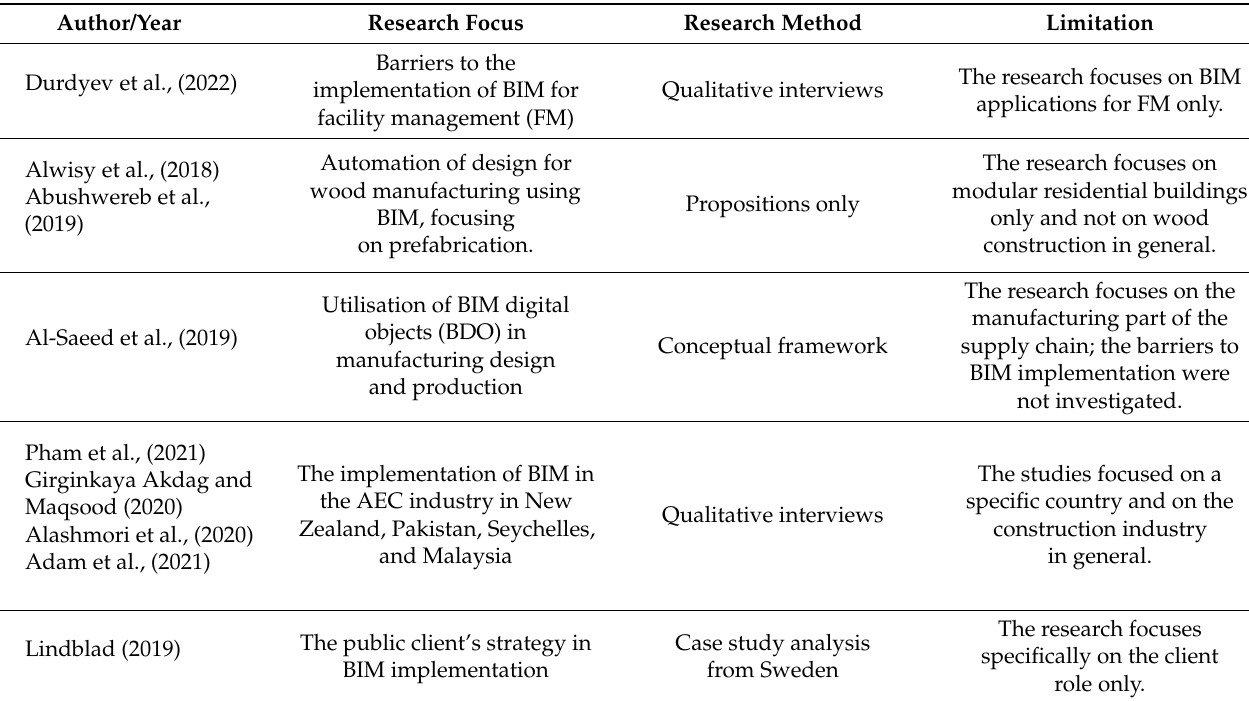
Table 2. Relevant literature focus and